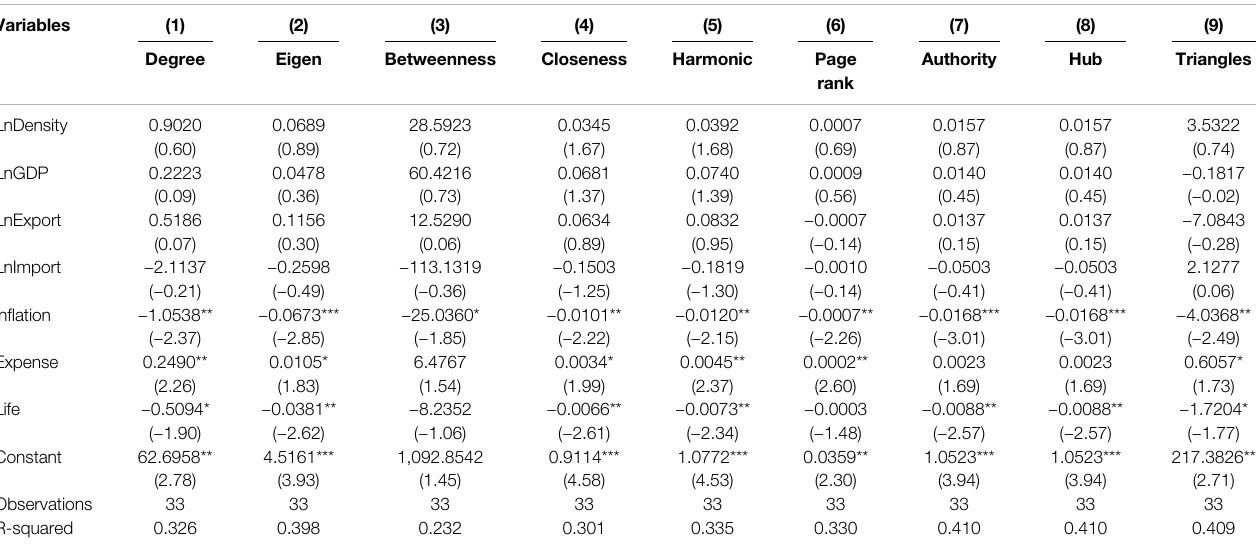
TABLE 4 | Determinants of connectedness: